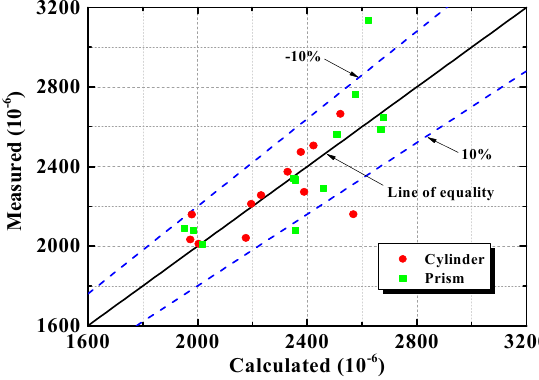
Figure 14. Calculated and measured ε *,300,CC .